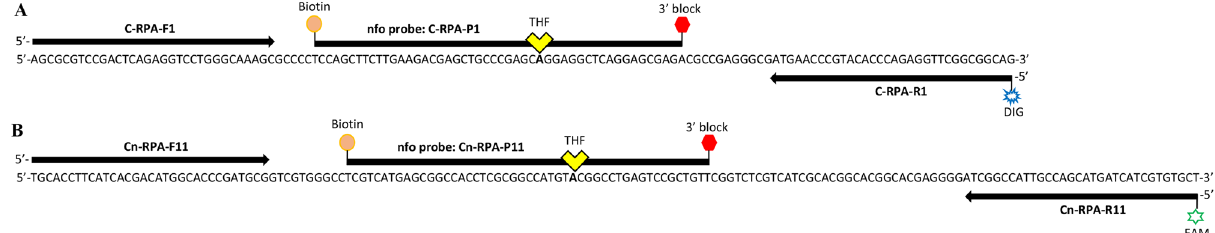
Figure 1. Multiplex RPA primer and probe locations developed to specifically detect genus Clavibacter ( A ) and C. nebraskensis ( B ) . ( A ) Target fragment size 129 bp, reverse primer labeled with DIG; ( B ) Target fragment size 156 bp, reverse primer labeled with FAM. The probe and primer are 49- and 32-bp long, respectively. THF- tetrahydrofuran residue; DIG-digoxigenin;